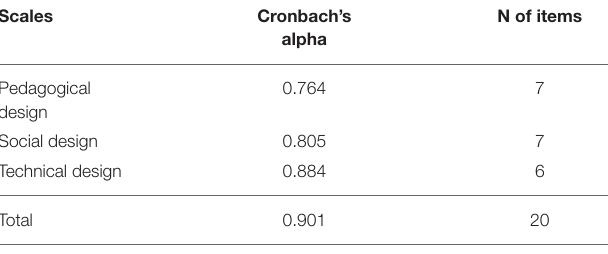
TABLE 4 | Cronbach alpha coefficients for modified WEBLEI.